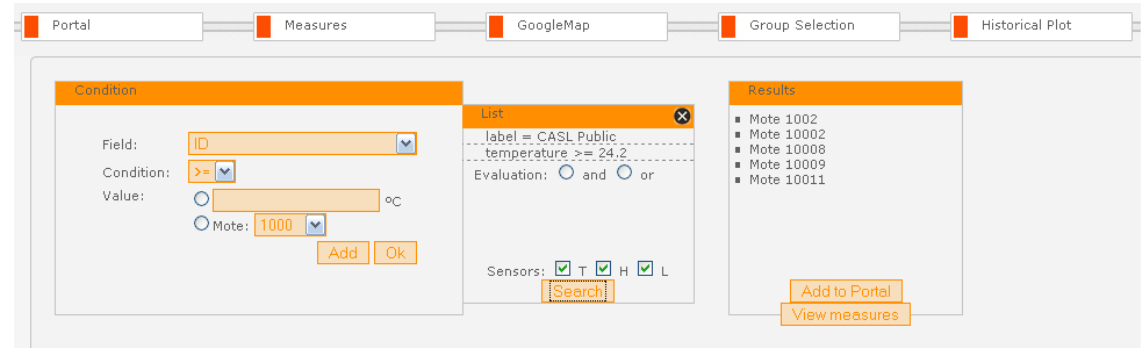
Figure 9. Sensor group selection